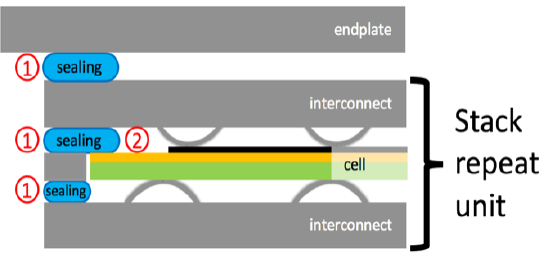
Figure 1. Detail of a stack scheme showing the position of sealing and its interfaces. ① indicates the sealing portions in contact with steel at both sides; ② indicates the sealing portions in contact with steel on one side and ceramic on the other side.